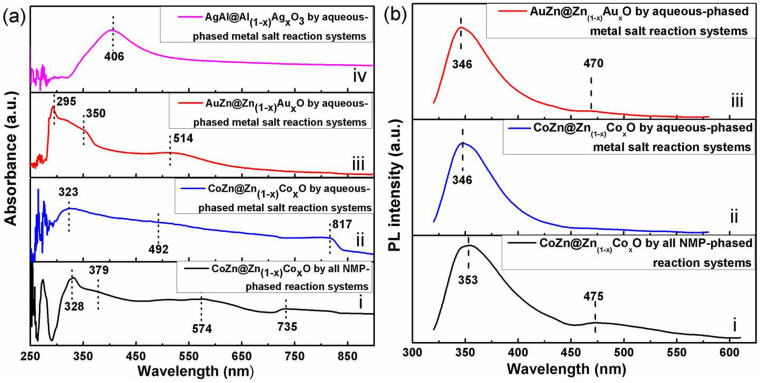
(a) UV-vis spectra of CoZn@Zn(1-x)CoxOy (i) nanohybrids synthesized using using all NMP-phased reaction systems, and CoZn@Zn(1-x)CoxOy (ii), AuZn@Zn(1-x)AuxOy (iii) and AgAl@Al(1-x)AgxOy (iv) nanohybrids synthesized aqueous-phased metal salt reaction systems. (b) Photoluminescent spectra of CoZn@Zn(1-x)CoxOy (i) synthesized using all NMP-phased reaction systems, and CoZn@Zn(1-x)CoxOy (ii) and AuZn@Zn(1-x)AuxOy (iii) nanohybrids synthesized using aqueous-phased metal salt reaction systems.